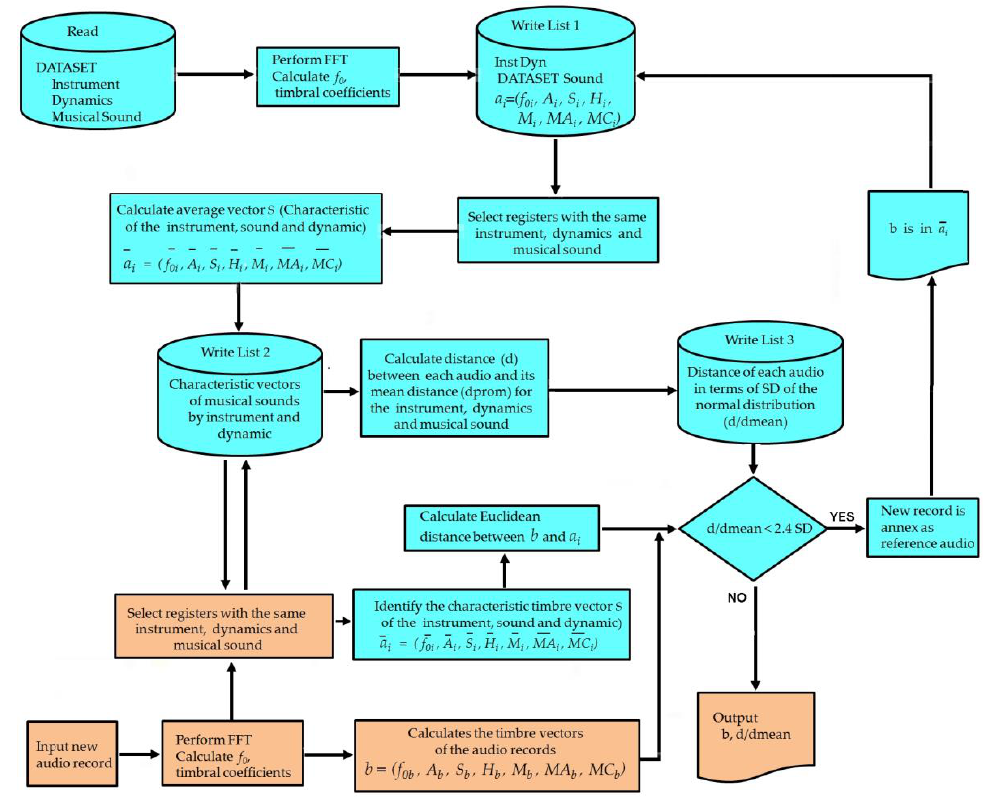
Figure 1. Flowchart diagram of the algorithm to calculate distances and relations of timbral similarity.